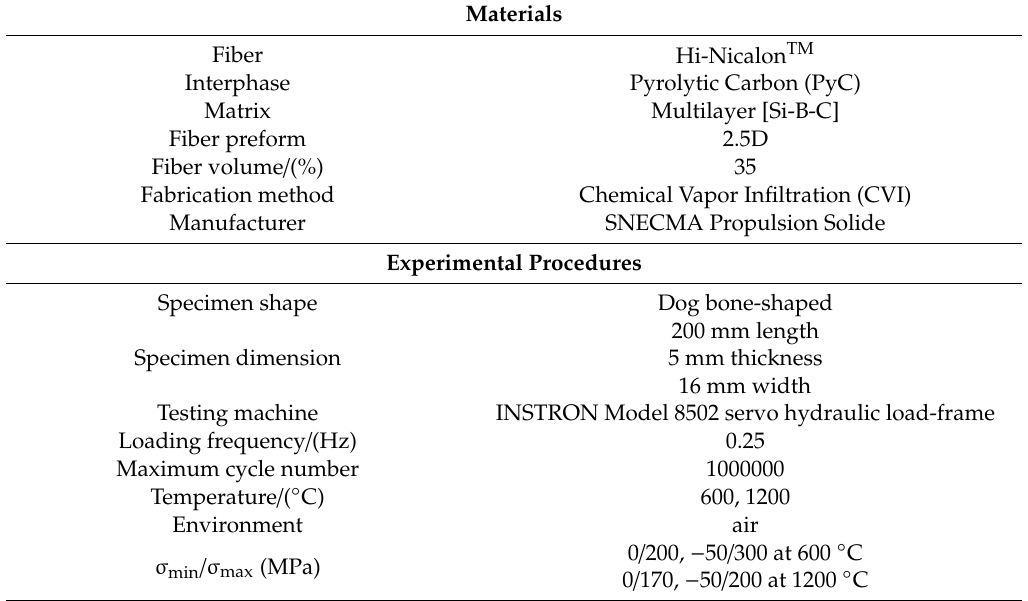
Table 1. Materials and experimental procedures of 2.5D woven Hi-Nicalon TM SiC / [Si-B-C] composite at 600 ◦ C and 1200 ◦ C in an air